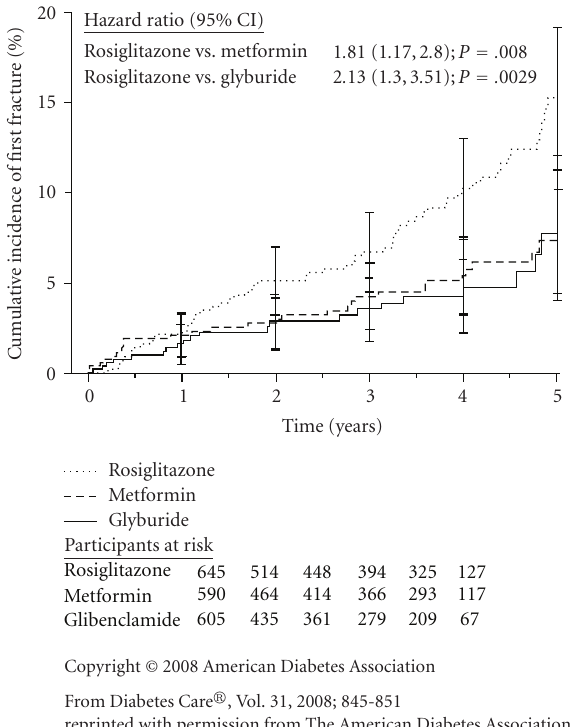
Figure 1: Kaplan-Meier estimates of the cumulative incidence of fractures at five years in women enrolled in ADOPT [3]. Bars represent 95% confidence